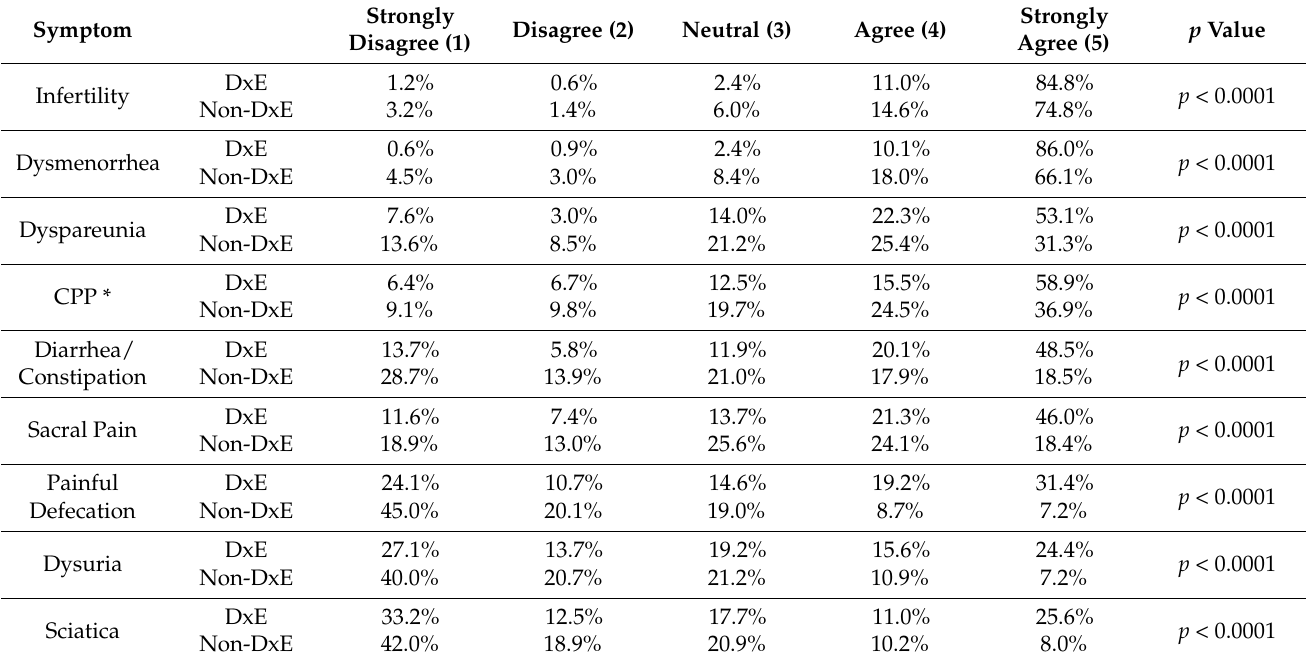
Table 3. Identification of symptoms according to respondents with endometriosis (DxE) and without endometriosis (Non-